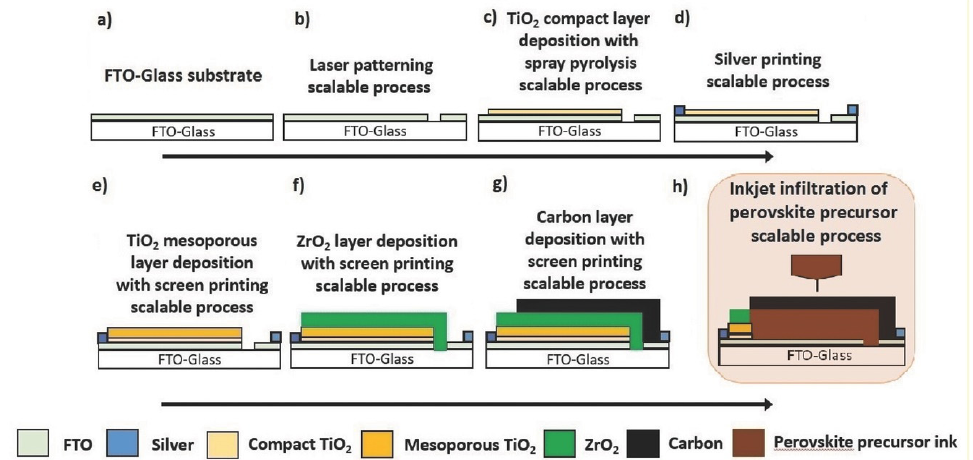
Figure 15 . Illustration of the scalable process to be employed for the production of HTM-free carbon- based PSCs. ( a ) FTO-coated glass substrate. ( b ) Laser patterning of the FTO layer. ( c ) Spray pyrolysis for compact TiO 2 layer deposition. ( d ) Screen printing of silver contacts. ( e ) Screen printing of a mesoporous TiO 2 layer. ( f ) Screen printing of an insulating ZrO 2 layer. ( g ) Screen printing of a porous carbon composite layer. ( h ) Inkjet of a controlled volume of perovskite precursor solution, which is targeted in this work [93]. (Reproduced from Ref. [93], 10.1002/admt.201600183, with permission.)